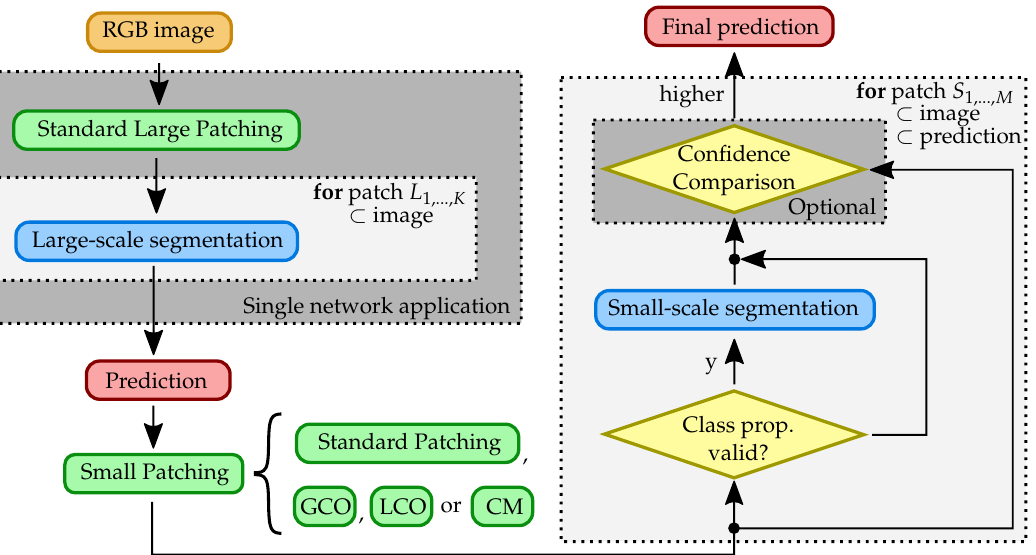
Figure 3. Visualization of the full pipeline starting with the RGB overview image (orange, upper left ) and finishing with the final stitched segmentation mask (red, upper right ). The light gray boxes represent the iterative execution over the patches defined beforehand (green boxes). Blue boxes depict the execution of CNNs; yellow boxes represent a decision or comparison based on the input data or initially defined thresholds. Dark gray boxes represent optional or separately executable algorithm